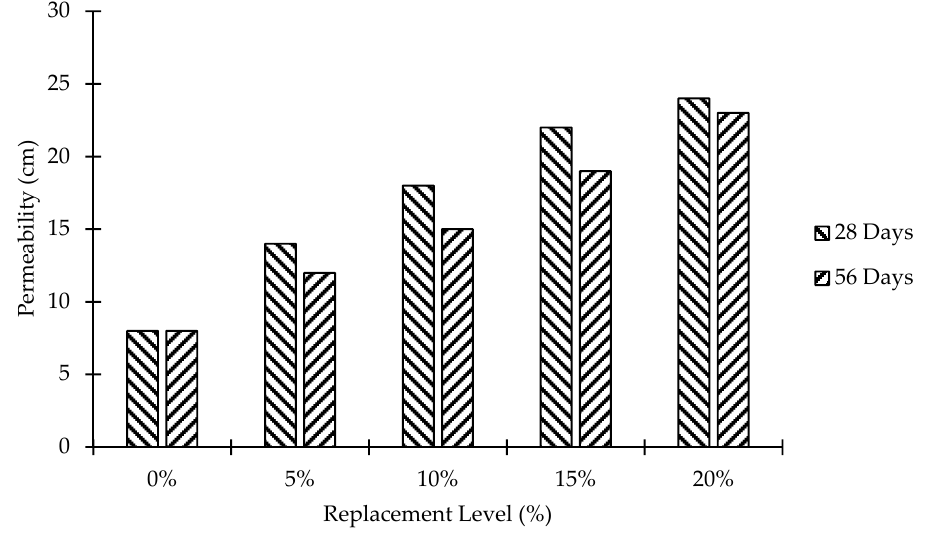
Figure 12. Replacement level versus permeability.